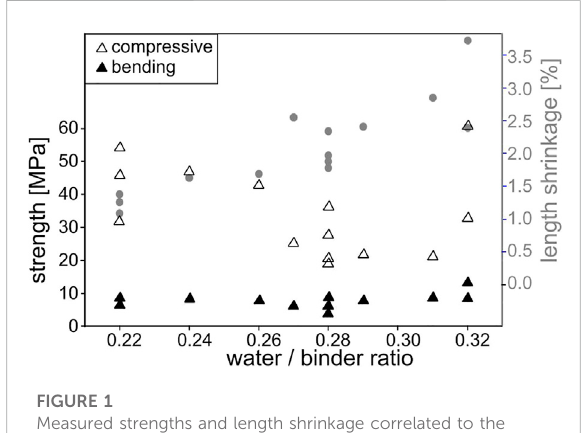
FIGURE 1 Measured strengths and length shrinkage correlated to the water/binder ratio of the prepared